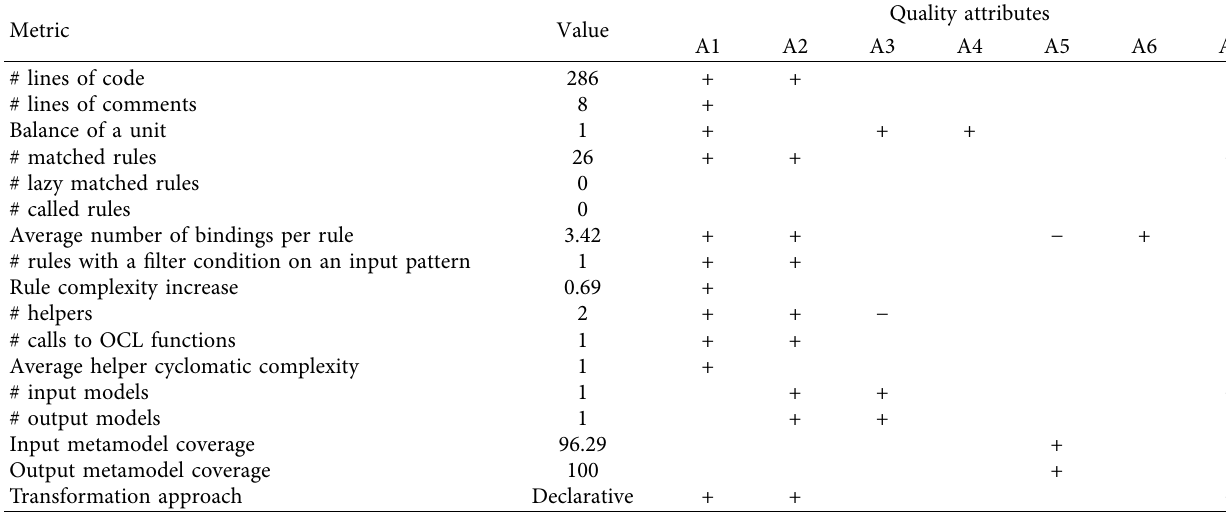
Table 6: Evaluation of the ATL transformations.